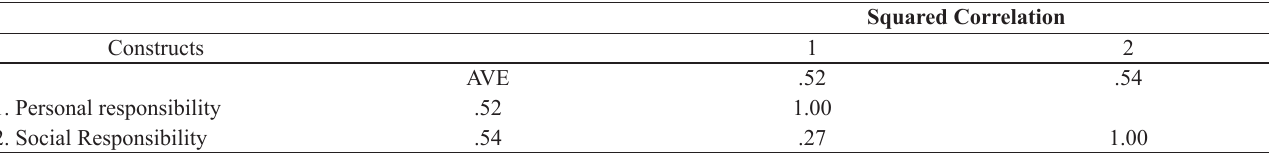
Table 3. Discriminant validity results for the constructs.